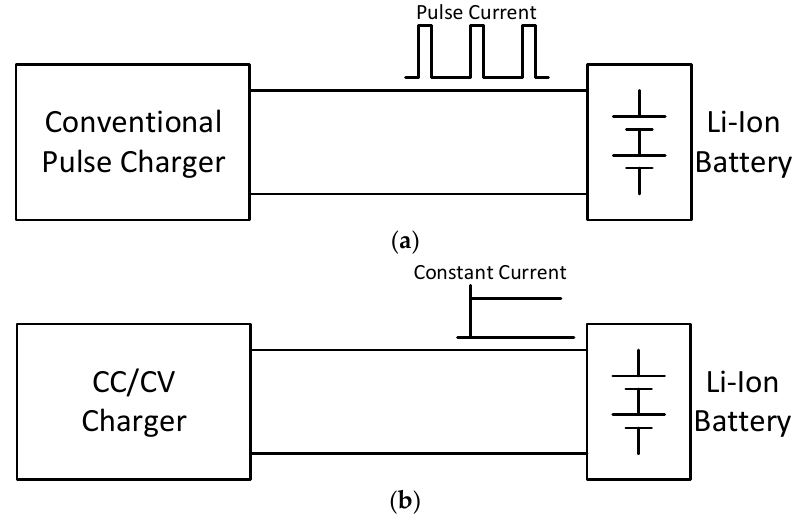
Figure 1. Structure of the conventional charging system. ( a ) Pulse charger ( b ) constant current–constant voltage (CC–CV) charger.